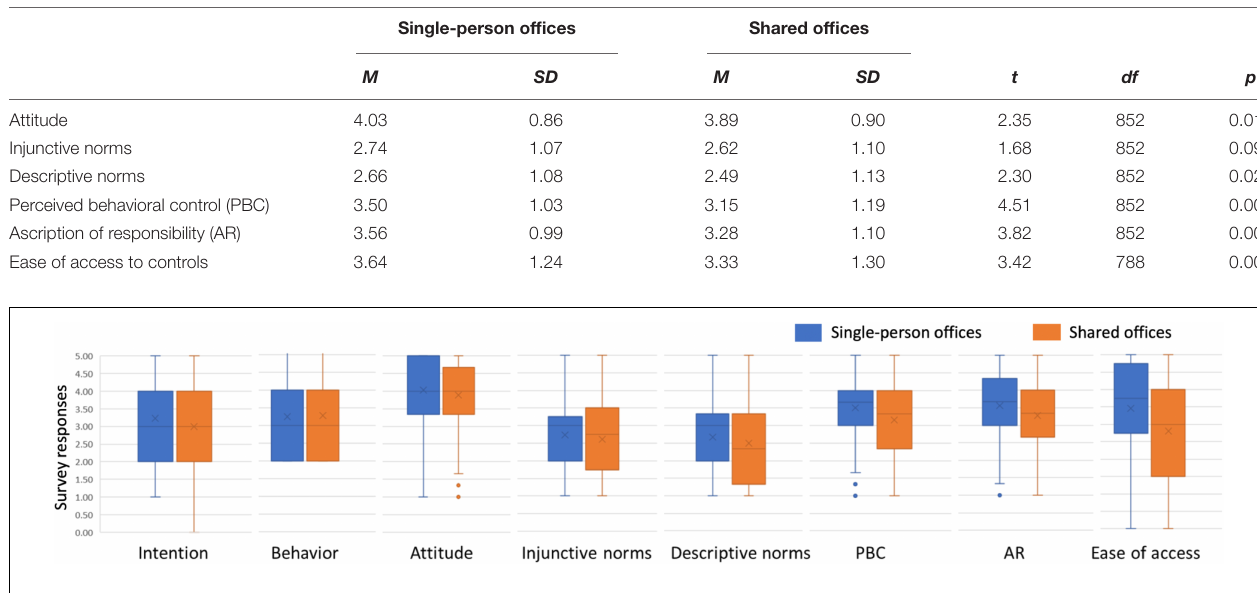
FIGURE 2 | The distribution of variables in single-person and shared